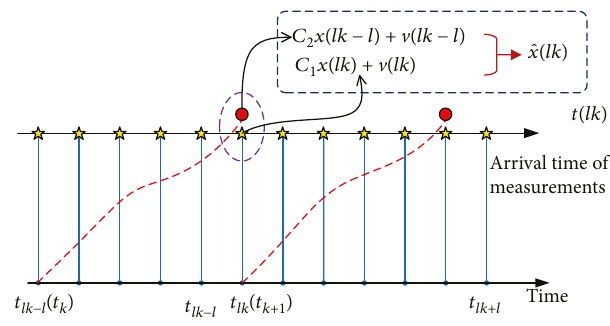
Figure 2: The core purpose of the proposed method.